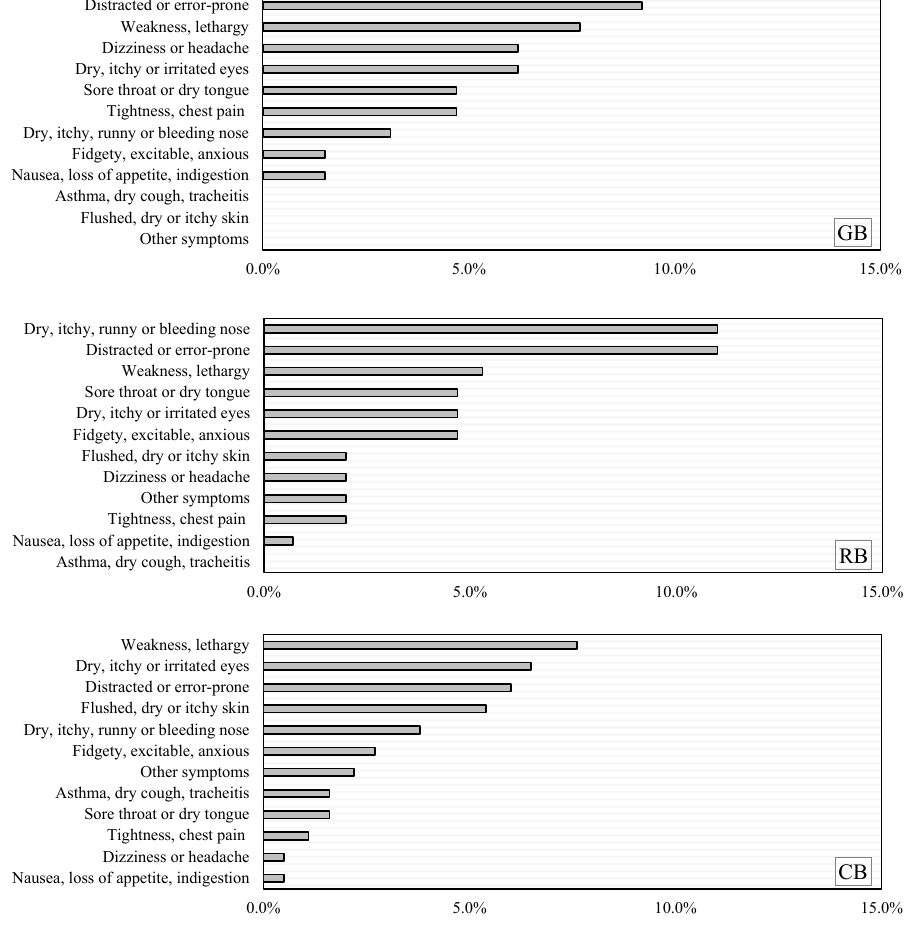
Figure 7. Comparison of the occurrence of SBS symptoms in the GB, RB, and CB.